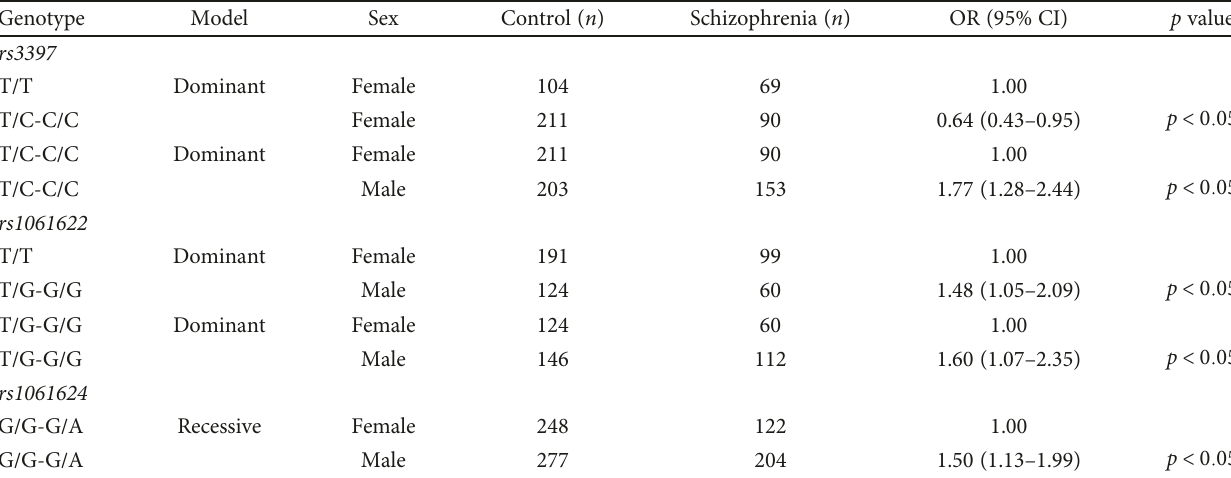
Table 2: Interaction analysis between polymorphisms of TNFR2 gene and sex on the risk of